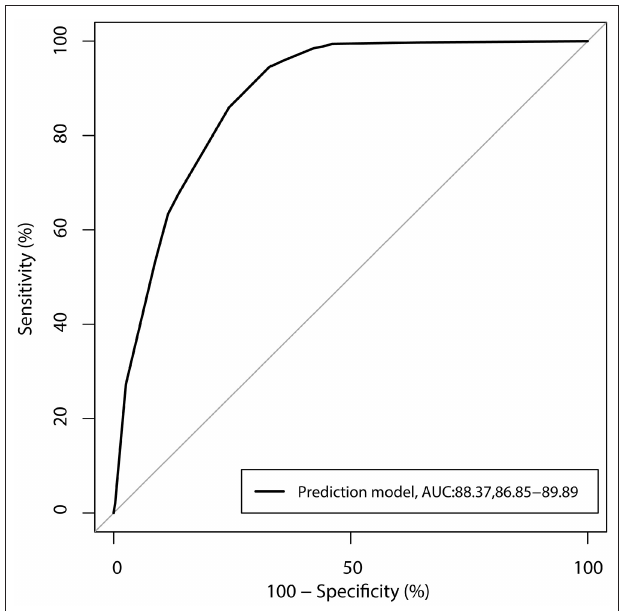
FIGURE 1 | Receiver operating characteristic curve for the risk of urinary tract infection, including the six-component risk factor model (area under the curve =